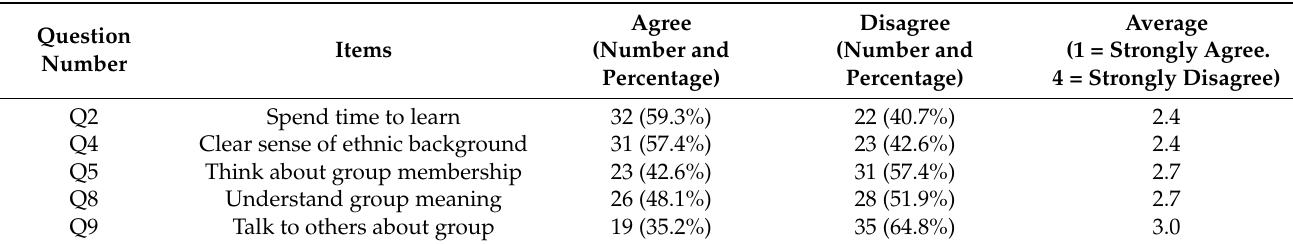
Table 4. Ethnic Identity Achievement